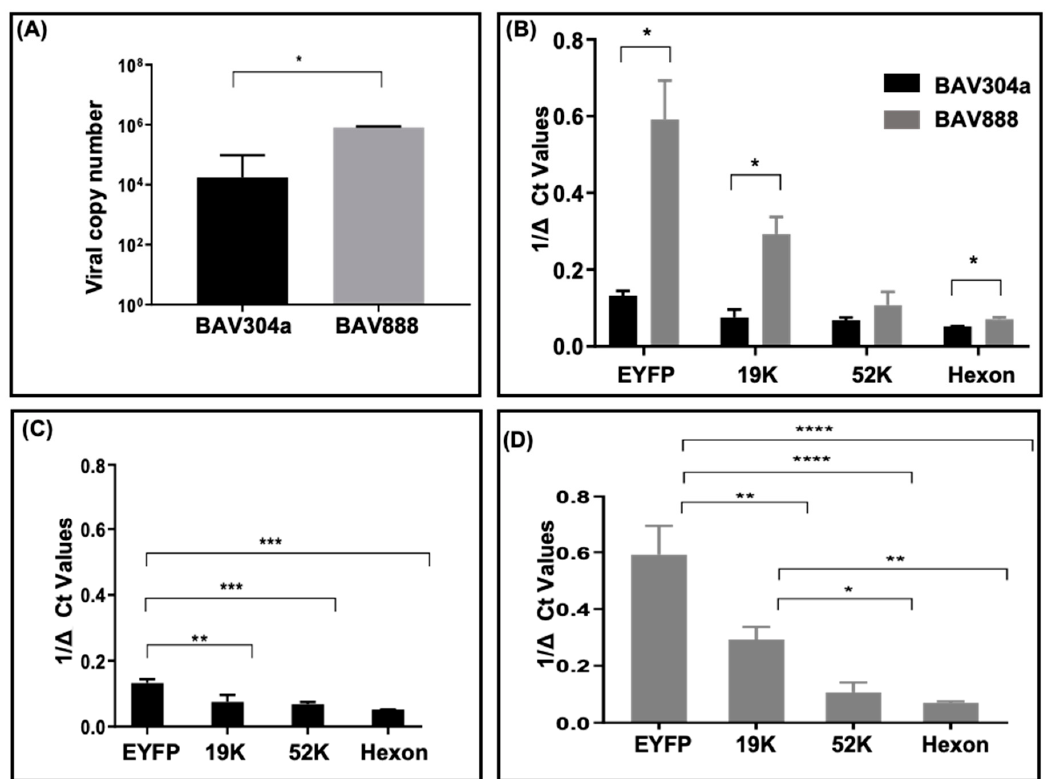
Figure 7. BAdV-3 genome copy number and viral gene expression in bovine monocytes. Monocytes (CD14 + cells) were isolated from PBMCs using MACS and transduced with either BAV304a or BAV888 using an MOI of 1. After 16 h, cells were collected and DNA and RNA were extracted. Total viral genome copy number recovered from each culture was quantified by qPCR ( A ). Expression of the EYFP gene and both early and late viral genes was quantified with qRT-PCR. Ct values for genes were normalized with β -actin ( Δ Ct) and presented as 1/ Δ Ct and compared for BAV304a- and BAV888-infected monocytes ( B ). Relative expression of EYFP and individual viral genes was compared for BAV304a ( C ) and BAV888 ( D ). Data presented are the mean + 1SD of values from three independent r experiments. * ( p < 0.05); ** ( p < 0.01); *** ( p < 0.001); **** ( p < 0.0001).